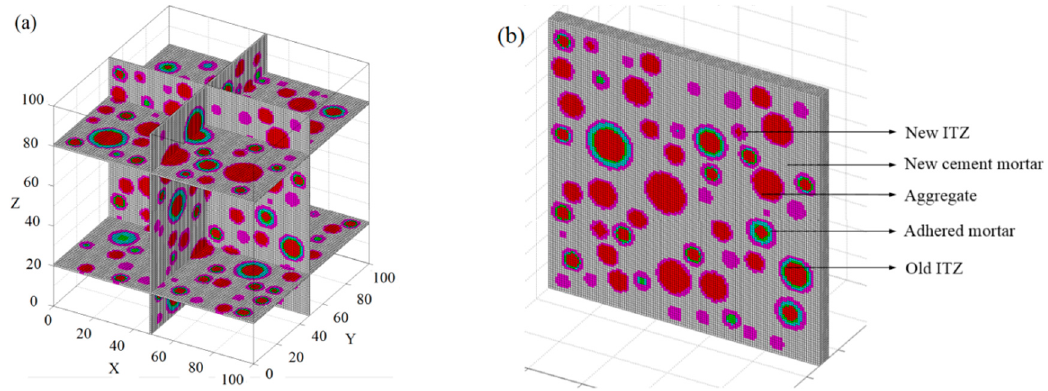
Figure 7. Slices and five-phase in the model. ( a ) Four slices in the model. ( b ) Five-phase system.